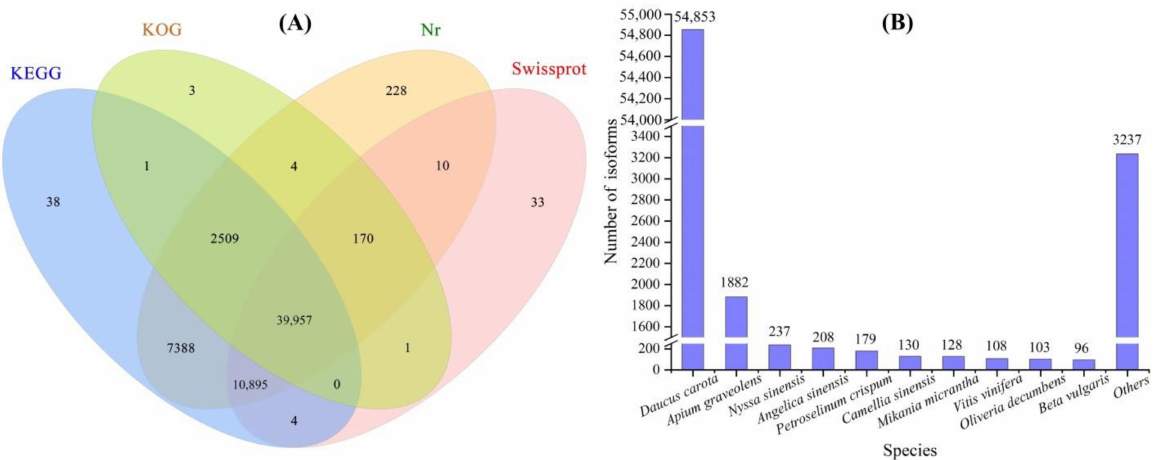
Figure 1. Basic annotation of full-length isoforms against KEGG, KOG, Nr and Swiss-Prot databases ( A ) and top 10 species in terms of distribution of the isoforms against Nr ( B